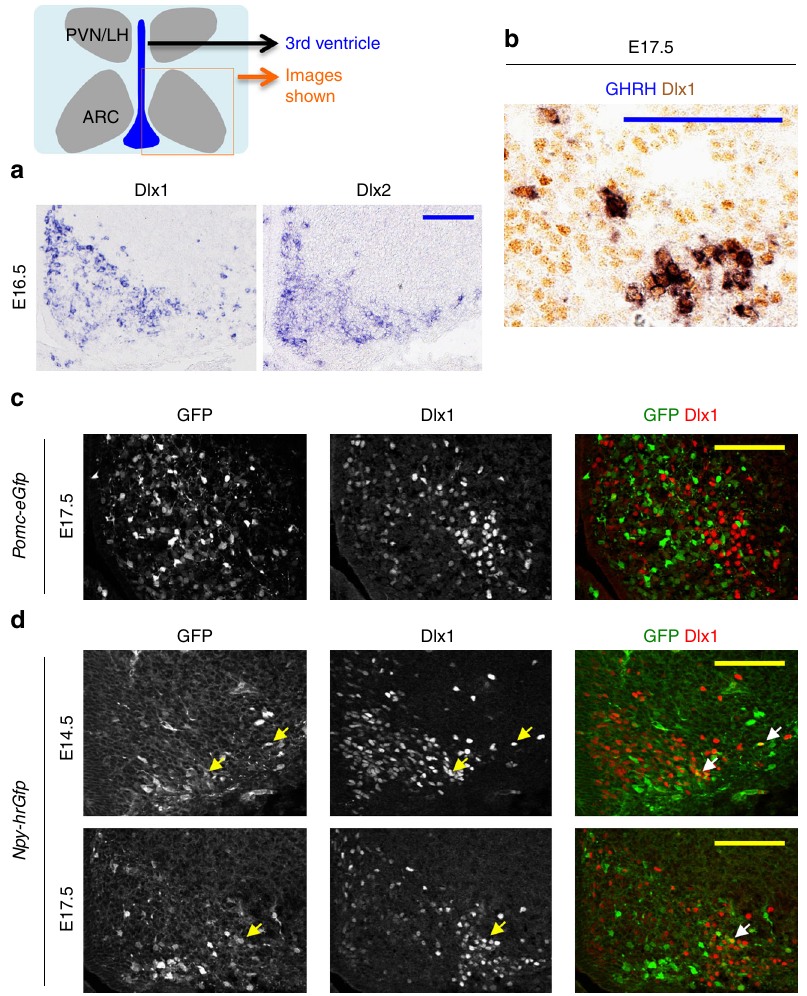
Fig. 1 Expression of Dlx1 in the developing ARC. a , b In situ hybridization (ISH) for Dlx1 and Dlx2 ( a ) and ISH for GHRH combined with immunohistochemistry (IHC) for Dlx1 ( b ). A total of 88.5 ± 5% of GHRH + cells were Dlx1 + cells in IHC ( b ). c , d IHC analyses of Dlx1 expression in Pomc- eGfp ( c ) and Npy-hrGfp ( d ) embryos using our home-made antibodies against Dlx1. In Pomc-eGfp , none of GFP + cells was Dlx1 + in IHC ( c ). In E14.5 Npy- hrGfp , 15 ± 1% of GFP + cells were Dlx1 + in IHC, while 93 ± 1% of Dlx1 + cells did not express GFP ( d ). In E17.5 Npy-hrGfp , 12 ± 2% of GFP + cells were Dlx1 + in IHC, while 90 ± 3% of Dlx1 + cells did not express GFP ( d ). Quanti fi cation was performed with multiple embryos and at least three sections from each embryo, and representative images for only one side of the ARC are as shown. Scale bars, 100 μ